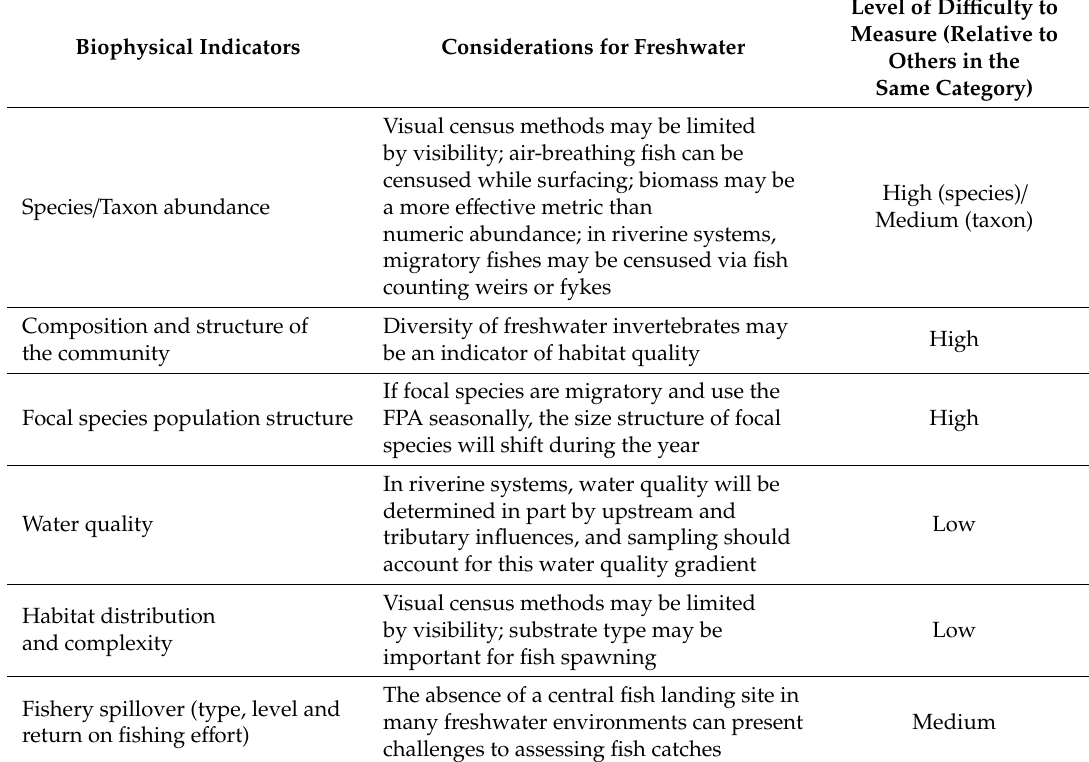
Table 2. Considerations for measuring common APA e ff ectiveness indicators in a freshwater community management